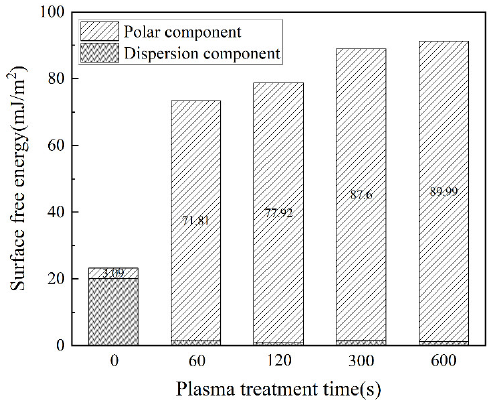
Figure 15. Surface free energy of CF/EP with different plasma treatment